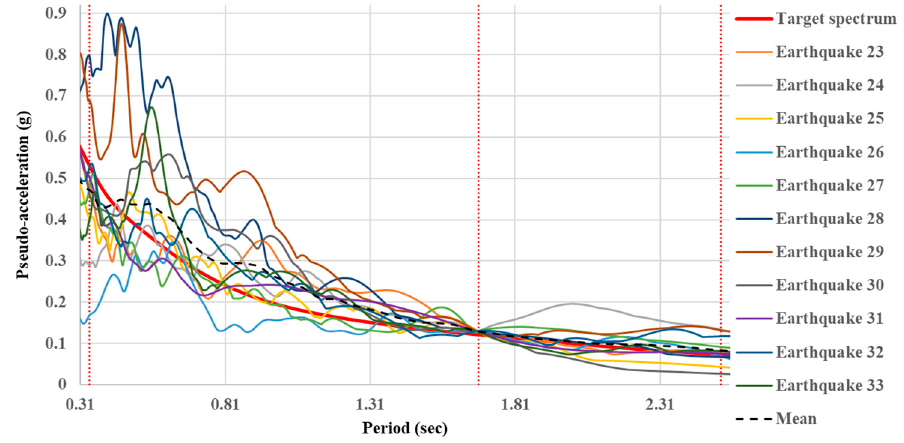
Figure 7. Ground motion selection for Agua Prieta, Sonora, corresponding to a return period of 2475 years with respect to the reinforced concrete building.